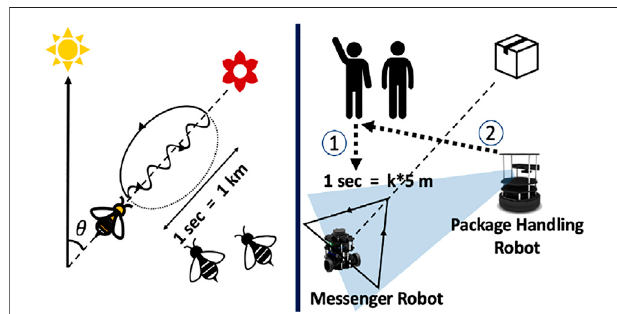
FIGURE1| Ananalogicalexampleofhowbeescommunicatetoconvey distance and direction of food source. The framework used in this paper involves a robot that moves in a triangle to convey direction and distance towards the target destination for the other robot.in cooperation with humans.